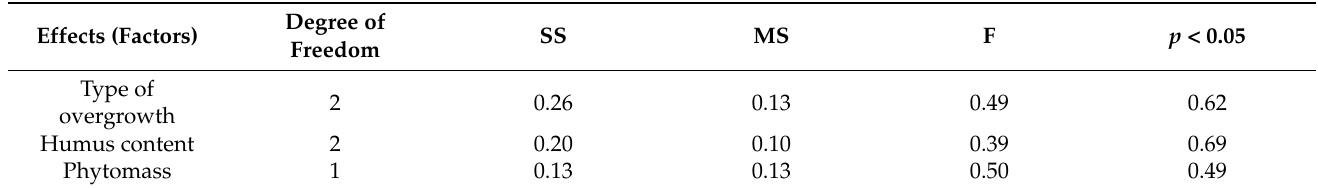
Table 5. Results of factor analysis for the biodiversity of herbaceous vegetation in post-agrogenic